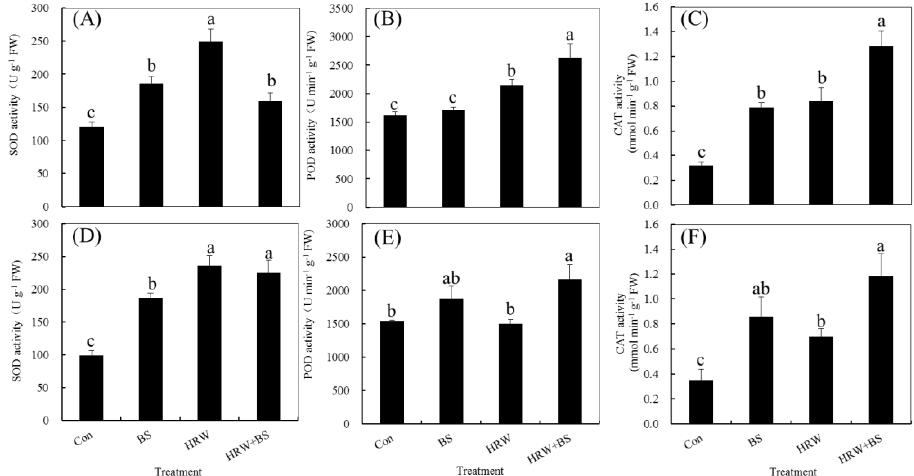
Figure 3. Effects of the HRW (hydrogen-rich water) pretreatment on SOD (superoxide dismutase) ( A , D ), POD (peroxidase) ( B , E ), and CAT (catalase) ( C , F ) activity in the leaves of two rice cultivars under BS (Bispyribac-sodium) stress. HRW and BS indicate treatment with HRW (hydrogen-rich water) and BS (Bispyribac-sodium) alone, respectively; HRW + BS indicates the co-treatment with HRW and BS. The leaves were pretreated with 75% saturation of HRW for 24 h, followed by the application of BS at 30 g a.i./hm 2 . Each enzyme’s activity in indica rice seedlings ( A – C ) and japonica rice seedlings ( D – F ) was determined after five days. Bars are the mean ± SE from three independent experiments. Bars with different letters are significantly different at p < 0.05 according to Duncan’s multiple -range test.